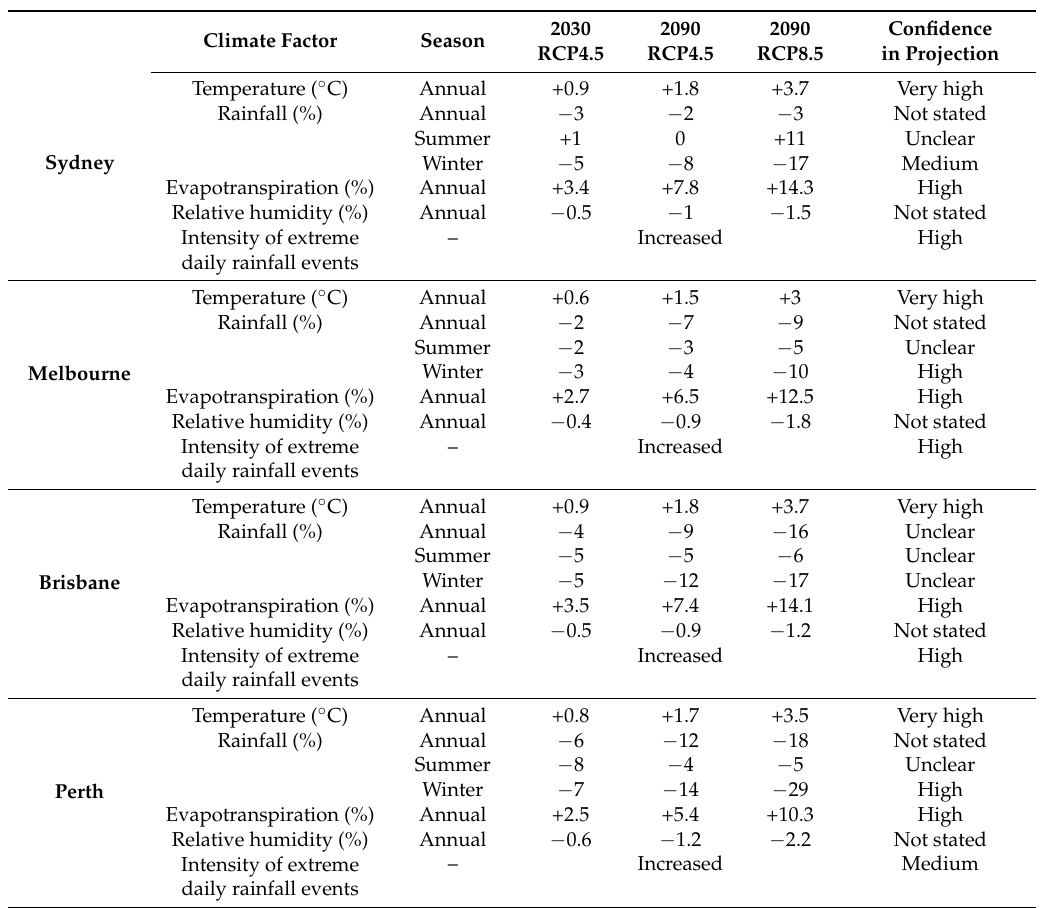
Table 1. Projected changes averaged across available CMIP5 GCMs for Comparison of projections for changes in temperature, rainfall, evapotranspiration, relative humidity, and the intensity of extreme daily rainfall events for 2030 and 2090 relative to the 1986–2005 average for the four largest cities in Australia from Webb and Hennessy [4]. The projections models shown are intermediate and high emission scenarios for greenhouse gases and aerosols, i.e., RCP4.5 and RCP8.5, respectively. For 2030, results for all RCPs are similar so only RCP4.5 values are shown